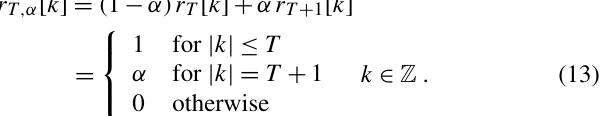
Figure 6. Plot of execution times from Table 3 against Gaussian width parameter. Both axes use a logarithmic